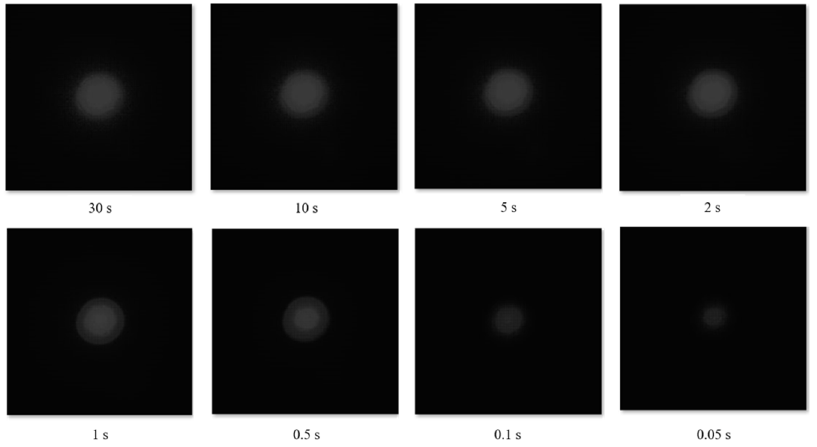
Figure 7. Raw pixel image change with exposure time at the wavelength of 440 nm. Raw images have a pixel value of 2 14 scale. The exposure time is between 0.05 and 30 s. have a pixel value of 2 14 scale. The exposure time is between 0.05 and 30